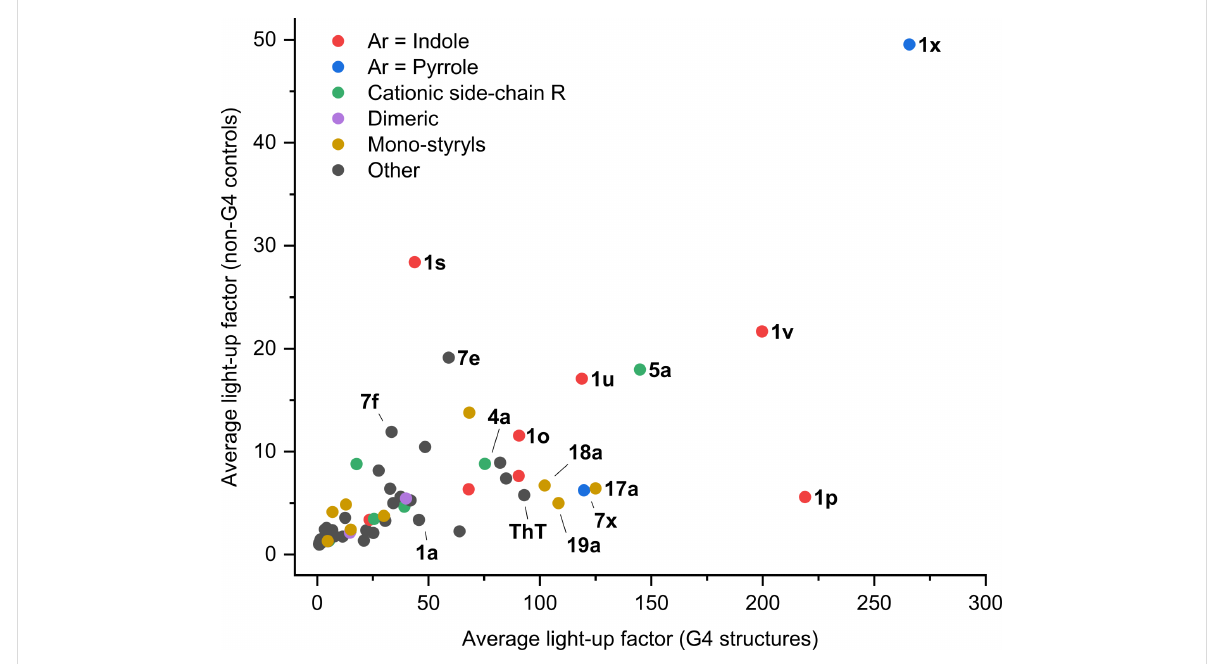
Figure 6: Analysis of the light-up response matrix of the dyes. The average light-up factor of each dye with respect to non-G4 targets ( ct DNA and cl RNA ) is plotted against the corresponding average light-up factor obtained with 12 G4 targets. The grouping of dyes is arbitrary and serves to high- light some of the structural motifs. Of note, x and y axes display different scales.